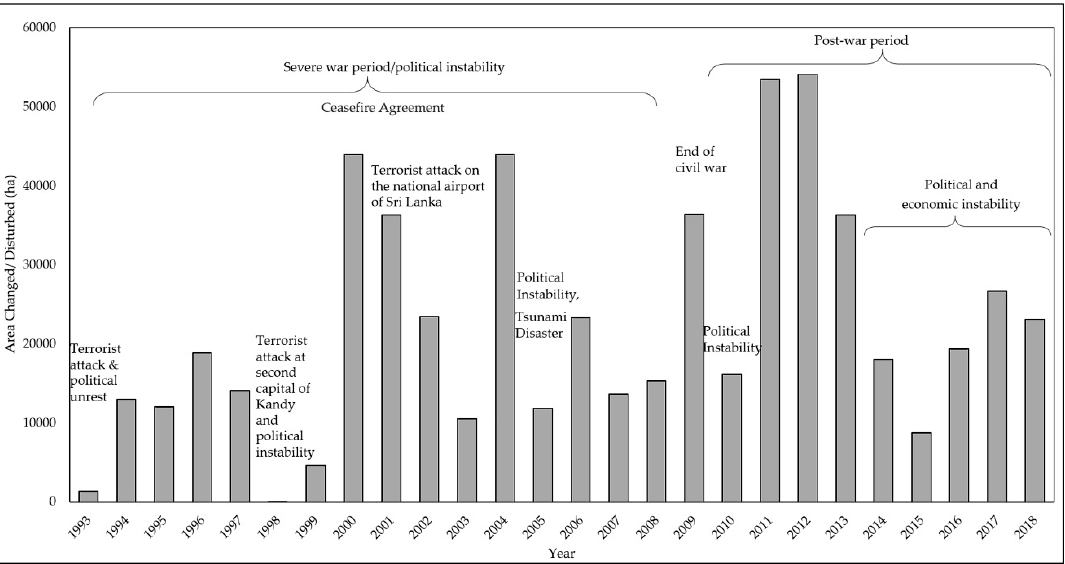
Figure 8. Annual total area changes/disturbances (ha) across all land cover classes and major historical events occurring in Sri Lanka from 1993 to 2018.